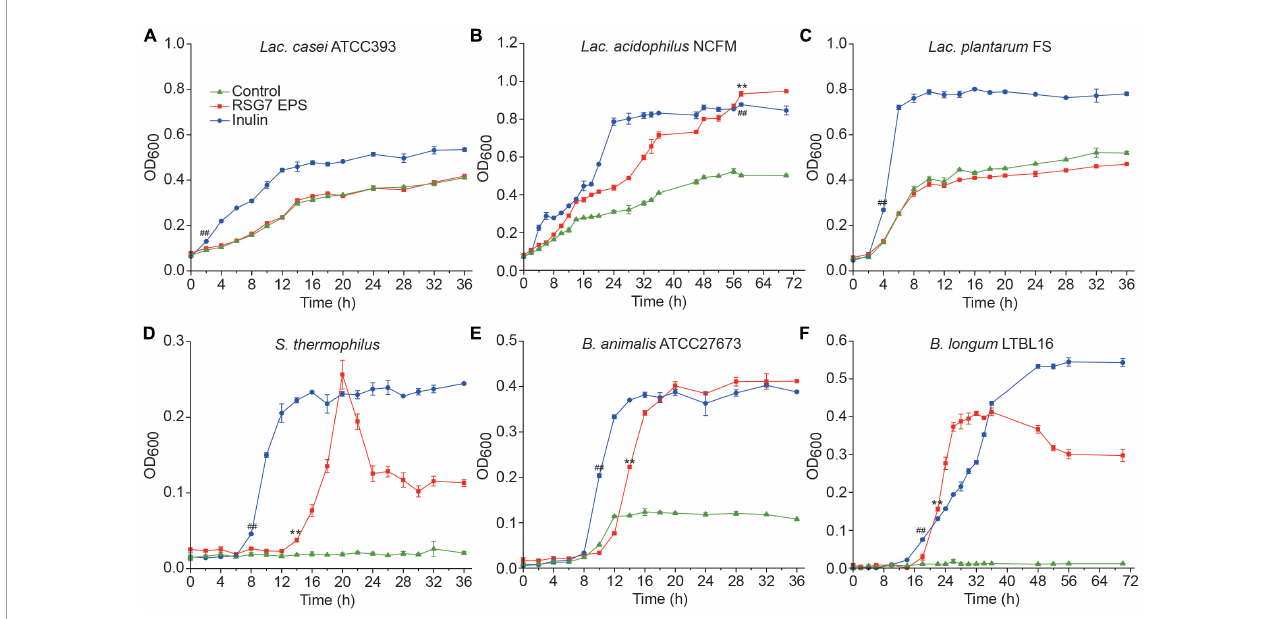
FIGURE12 Growth profiles of Lactobacillus , Streptococcus, and Bifidobacterium on glucose-free MRS added with different carbon sources at 37 ◦ C under anaerobic treatments. (A) Lac. casei ATCC 393, (B) Lac. acidophilus NCFM, (C) Lac. plantarum FS, (D) S. thermophilus , (E) B. animalis ATCC 27673, and (F) B. longum LTBL16. Each point represents mean ± SD of three determinations. p < 0.01 is indicated by ** for RSG7 dextran versus control, and p < 0.01 is indicated by ## for inulin versus